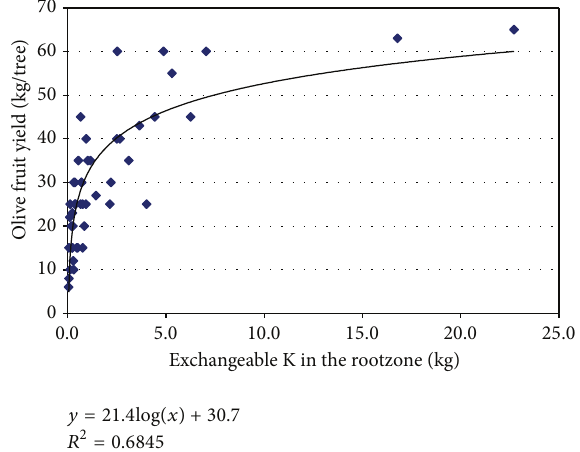
Figure 3: Regression between individual olive tree fruit yield ( 𝑁 = 47 ) and the amount of exchangeable potassium in the rootzone.